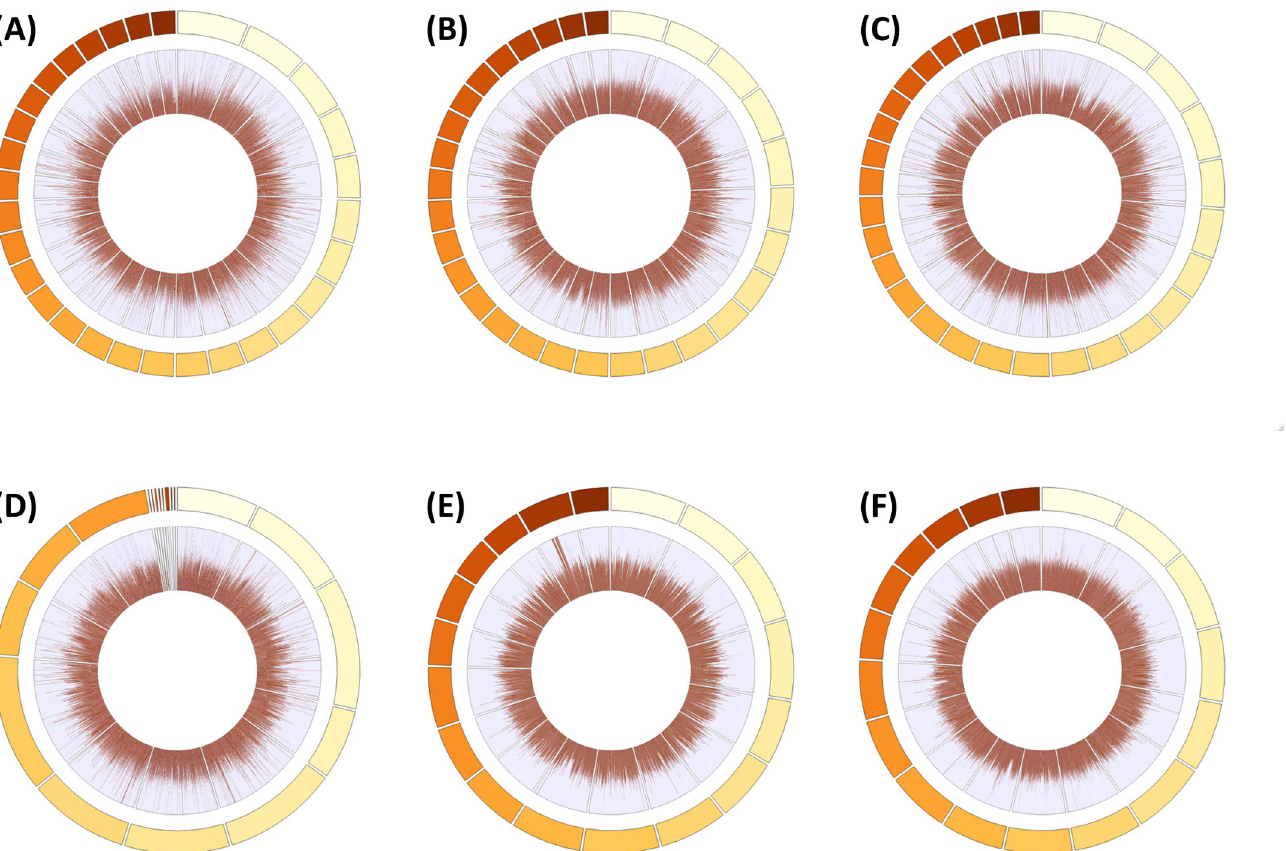
Fig 2. Coverage density of four cost-conscious short-read sequencing libraries generated with the presented protocol, across a corresponding de novo genome assembly independently generated with long-read sequencing. (A) Acacia acuminata . (B) Angohpora floribunda . (C) Corymbia maculata . (D) Eucalyptus melliodora . (E) Puccinia striiformis f. sp. tritici . (F) Puccinia triticina . Inner circumference represents coverage density, outer circumference represents the genome. Plots were generated by aligning the short-reads with BWA (v0.7.17) [18] to the corresponding long-read genome and calculating per-base read coverage with SAMtools (v1.12, depth tool, -a) [19]. Average coverage per 10 kb bins was calculated with BWA and plotted with the R package BioCircos [20]. A maximum of 30 largest (most contiguous) sequences for each assembly were plotted for